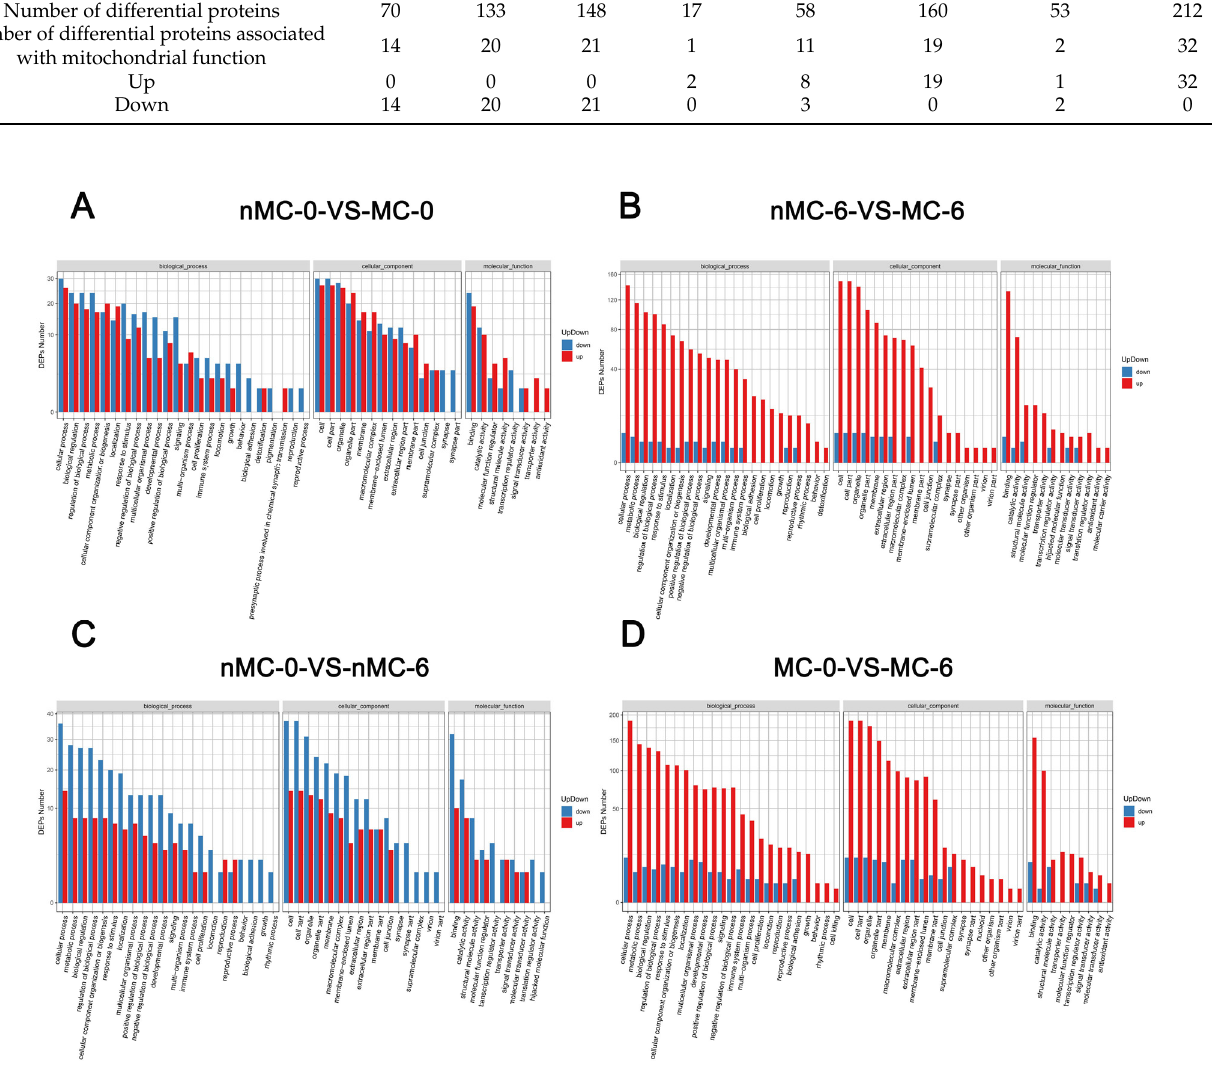
Figure 3. Differential protein GO function classification map of cryopreserved human oocytes from the nMC-0 group, MC-0 group, nMC-6 group and MC-6 group. ( A ) nMC-0 VS MC-0: Comparison of up-and down-regulated differential proteins between nMC-0 group and MC-0 group; ( B ) nMC-6 VS MC-6: Comparison of up-and down-regulated differential proteins between nMC-6 group and MC-6 group; ( C ) nMC-0 VS nMC-6: Comparison of up-and down-regulated differential proteins between nMC-0 group and nMC-6 group; ( D ) MC-0 VS MC-6: Comparison of up-and down-regulated differential proteins between MC-0 group and MC-6 group. The red represents up, the blue represents down.